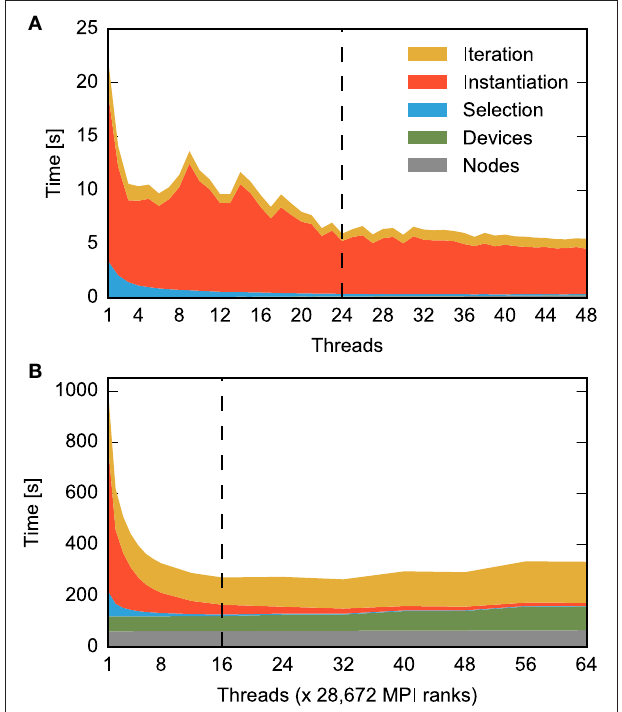
FIGURE 3 | Contributions to construction time for small and large neuronal networks for different numbers of threads. The time required for different construction steps is indicated by color and stacked: time for creation of network nodes (gray) and connecting devices to neurons (green) are shown in total, while the time for connecting neurons to each other using the fixed-indegree algorithm is further divided into the random selection of sources (blue), the instantiation of individual connections (red), and iteration over nodes (yellow). Listing 1 shows correspondingly colored code for the latter three components. A network of fixed size is distributed across increasing numbers of OpenMP threads (strong scaling). The dashed vertical line indicates the number of physical cores available on the compute node. Network construction is performed with instrumented code incurring runtime overhead compared to Figures 1 , 5 , 7 , see Section 2.5. (A) Construction of the small benchmark. Times required for creation of network nodes and for connections between devices and neurons are not visible. Same network model and machine as in Figure 1 . (B) Construction of a balanced random network model representing 200 million neurons and 2.25 trillion synapses (large benchmark, Table 1 , detailed model specification in Section 2.2.2) on an IBM BlueGene/Q supercomputer ( Table 1 , detailed system specification in Section 2.2.1). The benchmark emulates distributed computing on a